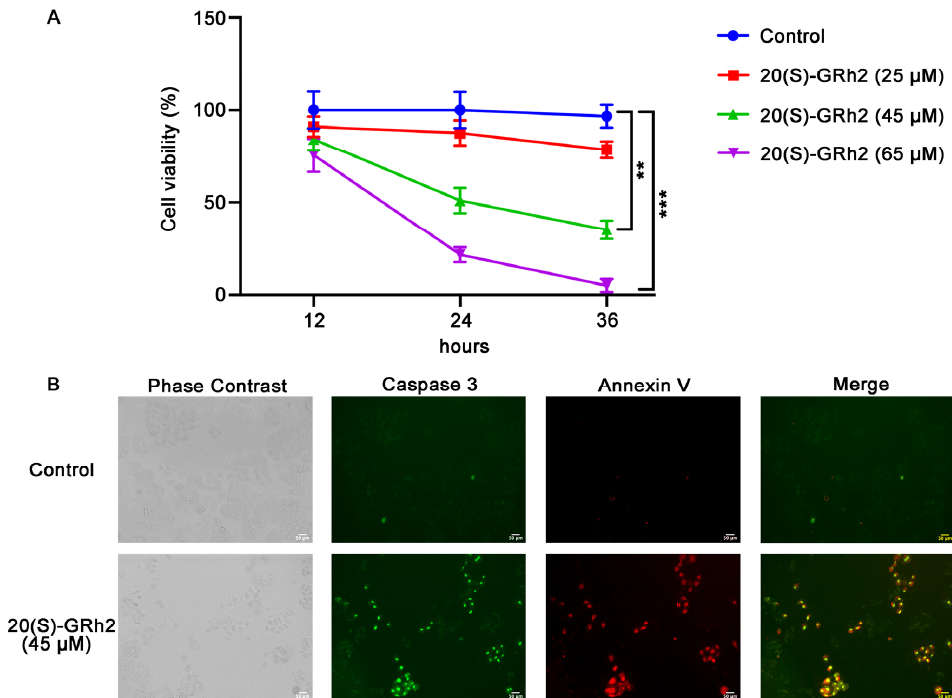
Figure 1. 20(S)-GRh2 inhibited HeLa cell proliferation and induced HeLa cell apoptosis. ( A ) HeLa cells were treated with control (0.1% v / v DMSO) or 25, 45, 65 μ M 20(S)-GRh2 at different time intervals (12 h, 24 h, 36 h), and CCK-8 assay was used to detect cell viability. Data are presented as mean ± standard deviation of three independent experiments (two-way ANOVA, ** p < 0.01, *** p < 0.001 vs. control). ( B ) Images of HeLa cells treated with 45 μ M 20(S)-GRh2 or control (0.1% v / v DMSO) and examined using the Live Cell Caspase-3 Activity and Annexin V Apoptosis Detection reagent. Green fluorescence represents caspase 3 activity, red fluorescence represents apoptotic cells, and phase contrast shows the total cells. The images are representative from three independent experiments. PS, phosphatidylserine; 20(S)-GRh2, 20(S)-ginsenoside Rh2.